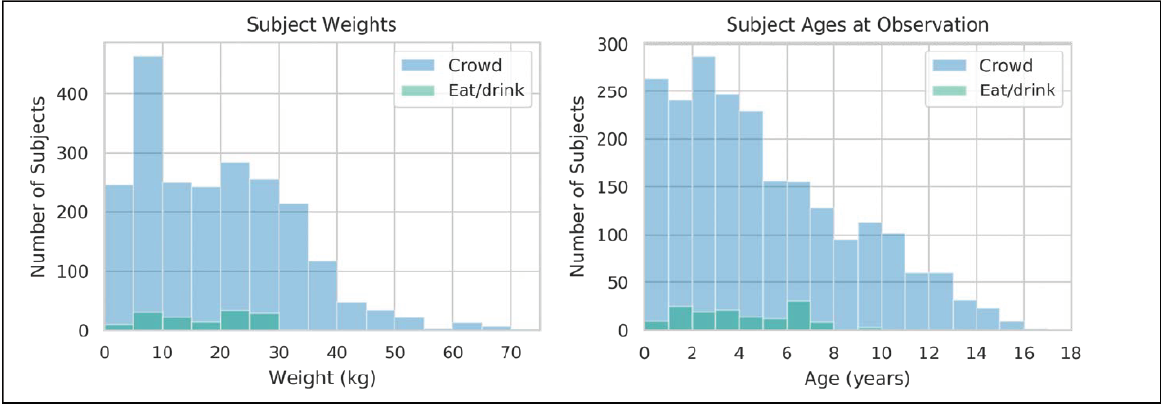
Figure 4. Weight and age distribution for the crowd and eat/drink datasets. Due to its more heterogeneous population, the crowd dataset had much greater variability than the eat/drink dataset. Table 4. Breed or breed category breakdown for the crowd and eat / drink datasets. Breed Crowd Breed